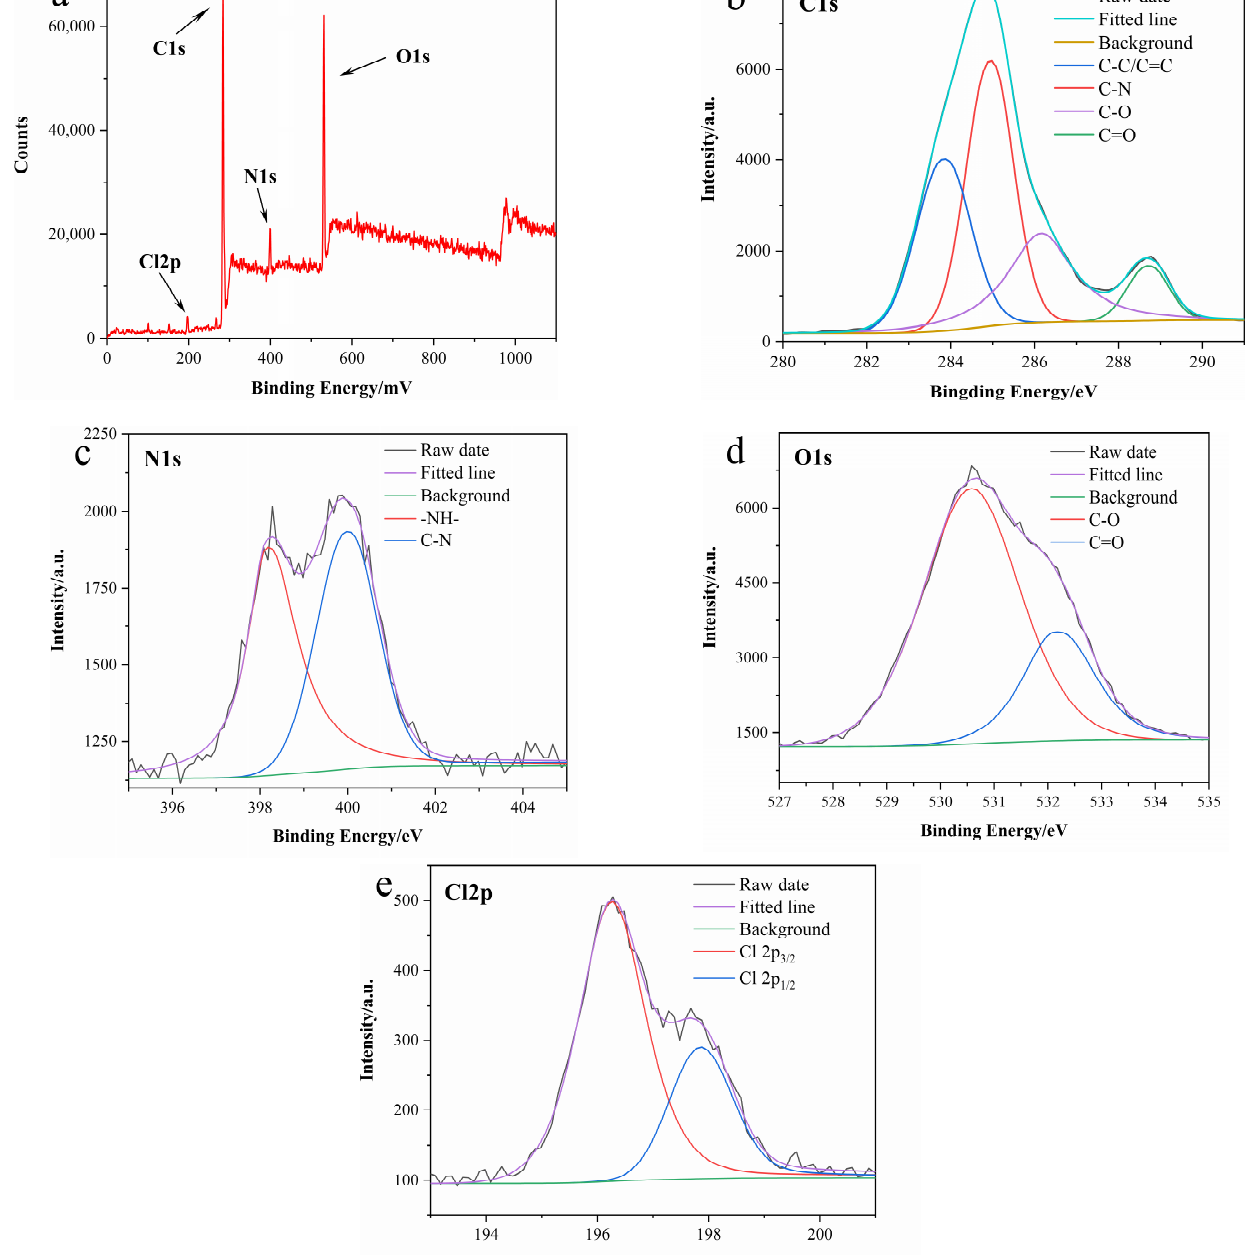
Figure 3. ( a ) XPS full spectrum; ( b – e ) high-resolution ( b ) C1s; ( c ) N1s; ( d ) O1s and ( e ) Cl2p XPS